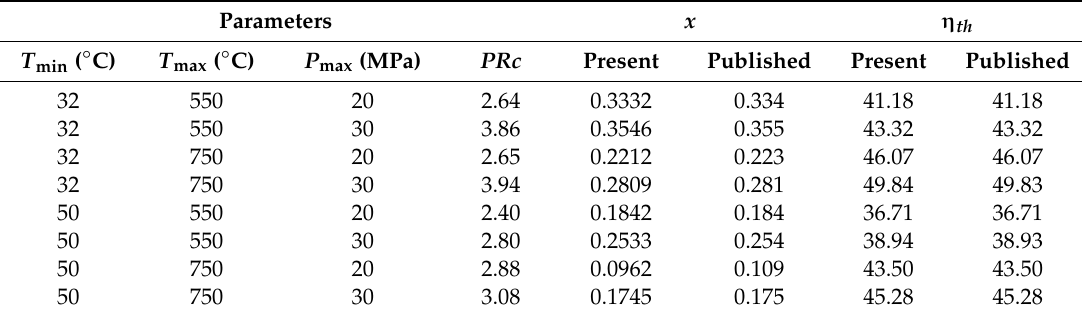
Table 6. Comparison between the simulated results and the published data for the sCO 2 cycle. Parameters x η th T min ( ◦ C) T max ( ◦ C) PRc Present Published Present Published